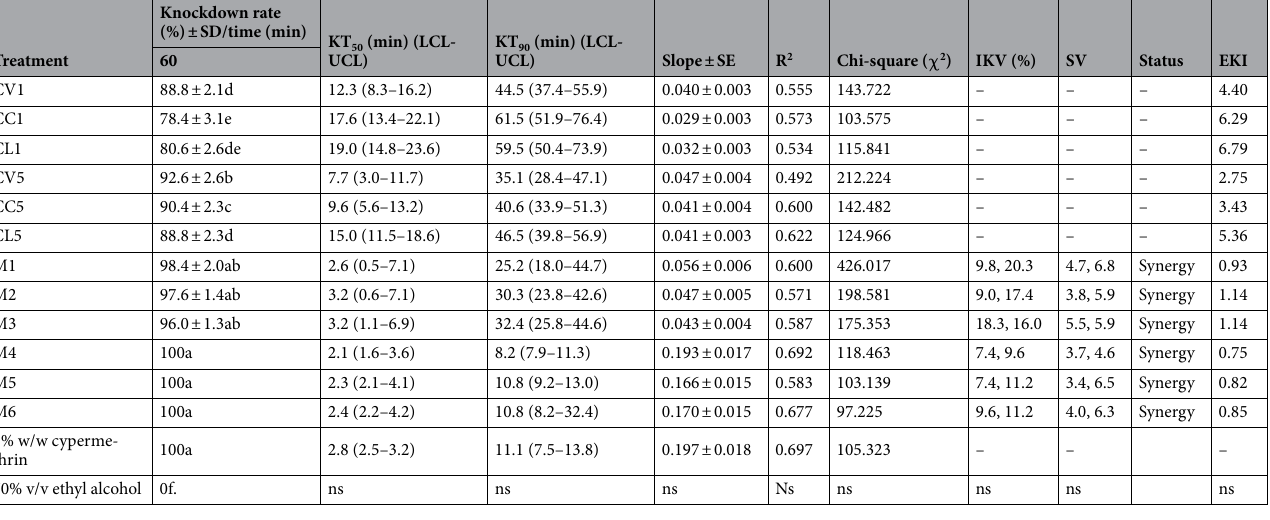
Table 2. Knockdown rates and KT 50 time of essential oils from C . verum , C . cassia , and C . loureiroi and their combinations against females of Ae . aegypti . Mean percentage knockdown rates in each column followed by a different letter are significantly different (one way ANOVA and Duncan’s multiple range test, P < 0.05). KT 50 50% knockdown time, R 2 regression coefficient, LCL lower confidence limit, UCL upper confidence limit, IKV